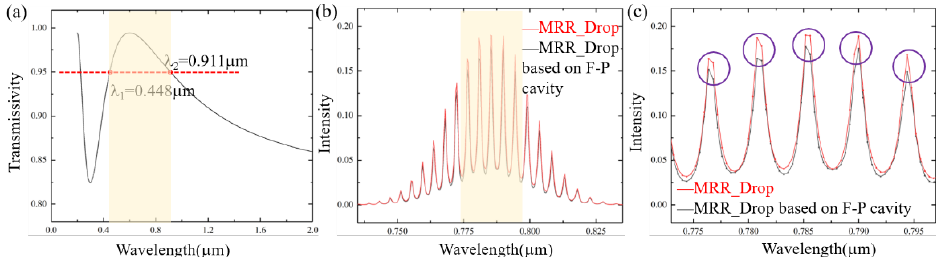
Figure 8. ( a ) Transmission spectrum after depositing 150 nm SiO 2 anti-reflection film. ( b ) When transmittance is 0.95, comparison of Drop signal with and without F-P effect. ( c ) Partial enlarged view of resonance peak signal.